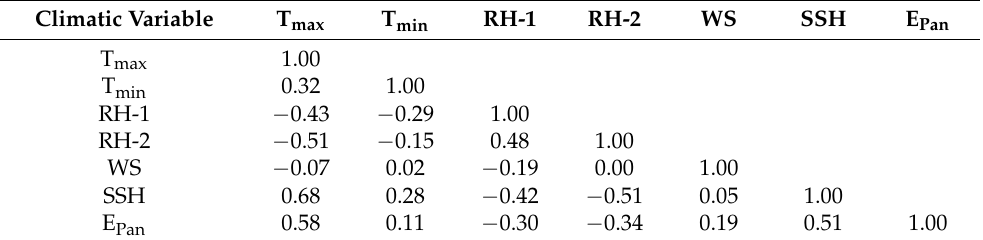
Table 2. Intercorrelation values between climatic parameters in the study area. Climatic Variable T